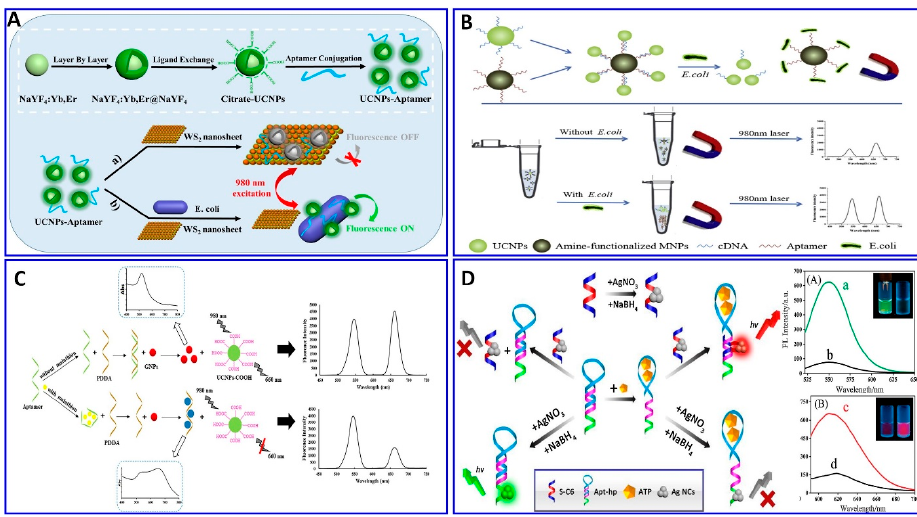
Figure 7. Schematic description of the ( A ) sensing platform for E. coli detection using fluorescent UCNP–WS2 nanosheet, reproduced from [140]. ( B ) Proposed fluorescence aptasensor for E. coli. using MNP–aptamer–cDNA–UCNP probe, reproduced from [141]. ( C ) Fluorometric aptasensor for malathion assay based on the FRET between UCNPs and GNPs, reproduced from [142]. ( D ) Proposed scheme of ATP assay based on ratiometric fluorescence from the binding between the ATP and aptamer complexes, reproduced from [145].